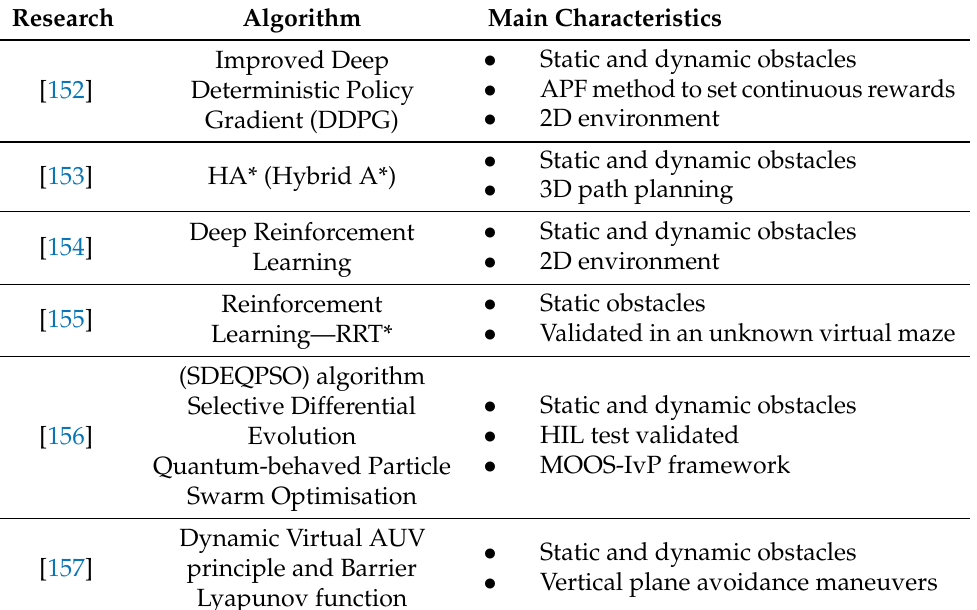
Table 8. List of algorithms validated in numerical research from 2021.